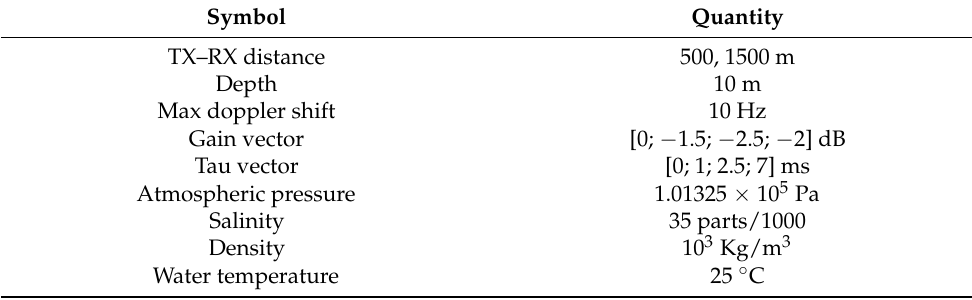
Table 4. Channel